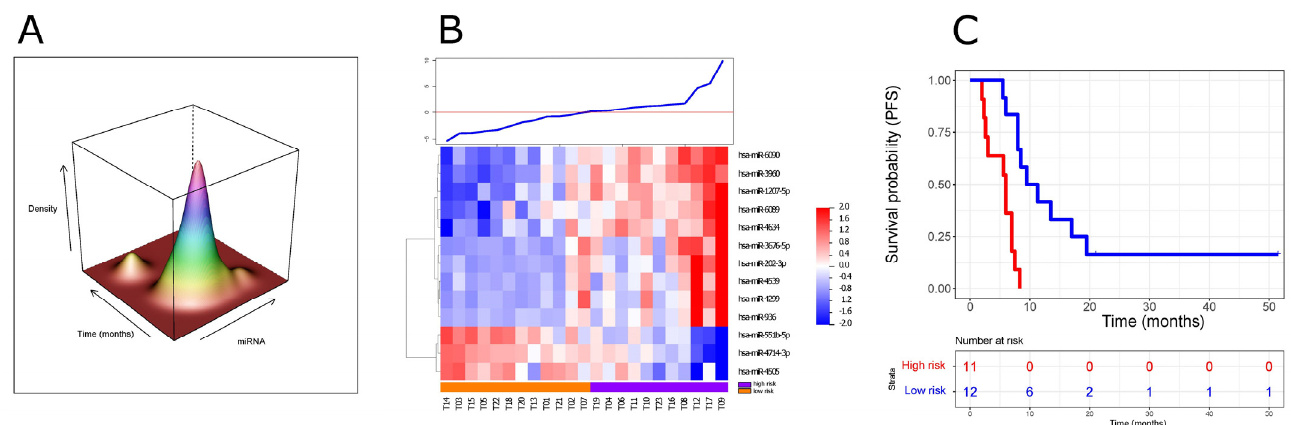
Figure 1. Prognostic signature based on ct-miRNAs from the training data set. ( A ) Joint density estimation for the ct-miRNA signature and time-to-event variable in the training set ( x -axis = miRNA model; y -axis = time-to-event; z -axis = density kernel estimate). ( B ) Heatmap of the expression levels related to the 13 miRNAs entering the signature. On the horizontal axis are the respective miRNAs; on the vertical axis are the patient samples ( n = 23). The samples are ranked based on the signature score, having the dividing threshold at 0.007481 defining those of a low or high risk, and the line plot above the heatmap summarizes the score value per sample. ( C ) Kaplan–Meier survival curves for patients predicted to be at high (blue, n = 11) or low (red, n = 12) risk of cancer progression. High-risk patients had a shorter PFS (progression-free survival) than those at low risk (log-rank test, p = 0.00014; hazard ratio (HR) = 7.99, 95% confidence interval (CI) 2.38–26.87). The permutation test (based on 100 permutations) had a p -value of 0.03, indicating a low probability of overfitting for the above-mentioned log-rank analysis. The Schoenfeld individual test was assessed to test Cox regression assumption and to discard any violation considering the fast dip to zero trend for the high-risk cases in contrast to the low-risk cases. Since the Schoenfeld individual test reaches p = 0.911, the test is not statistically significant and, therefore, we can assume the proportional